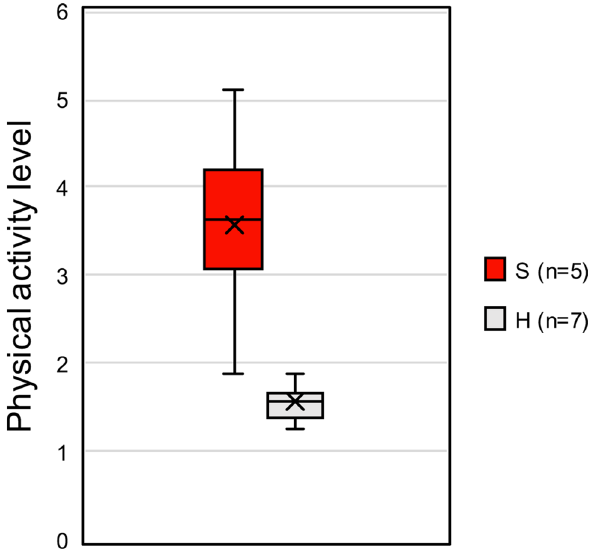
Figure 2. Box plot of physical activity level (DEE divided by RMR) in haplorhines (H) and strepsirhines (S). Mean value is indicated as X, close to the median (horizontal line inside the box). Upper and lower quartiles are shown as well as whiskers indicating the ranges for the bottom and top 25% of the data values.